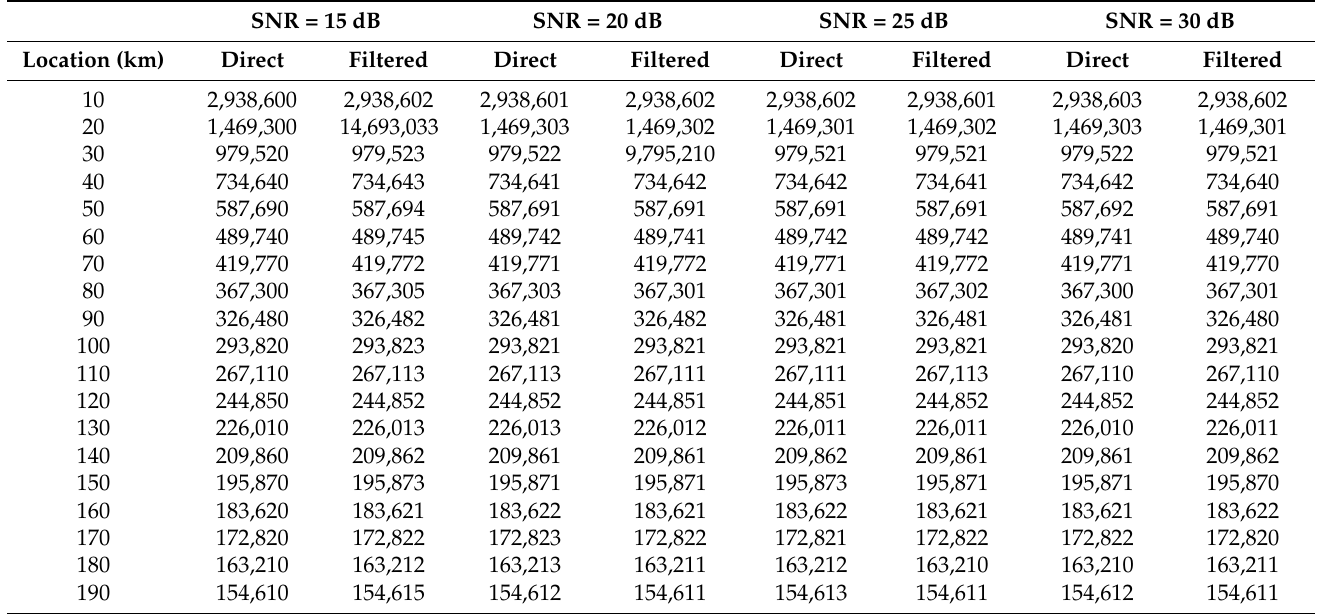
Table A3. Max singular value of FRFT-SVD results at various SNRs for direct and filtered signals under LLL fault